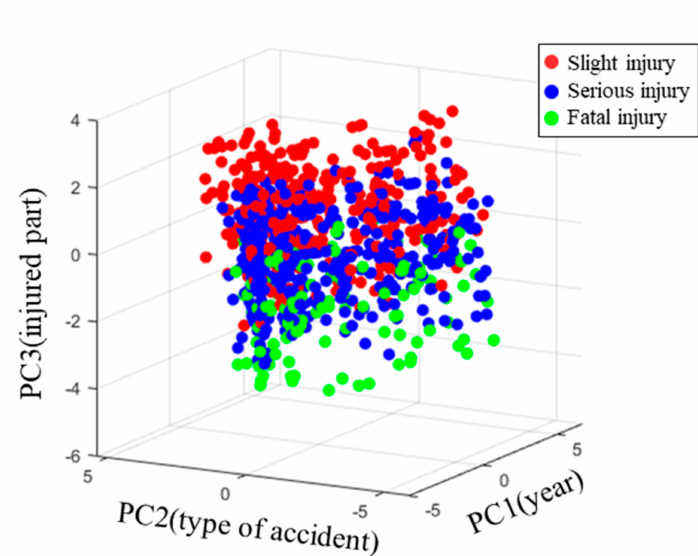
Figure 8. Classification of severity with principal component analysis (PCA) using three major